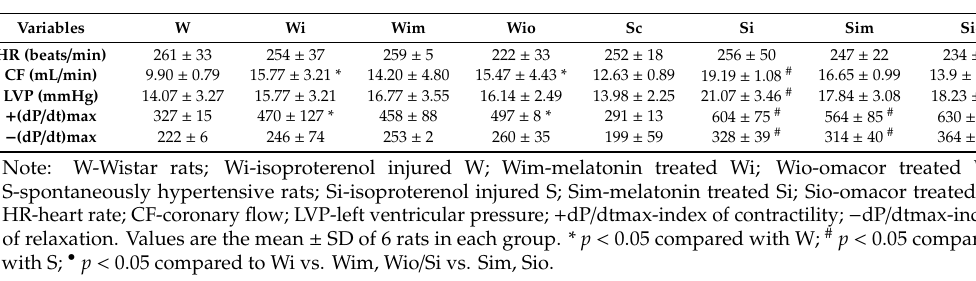
Table 3. Baseline values of the isolated perfused heart of experimental rats.